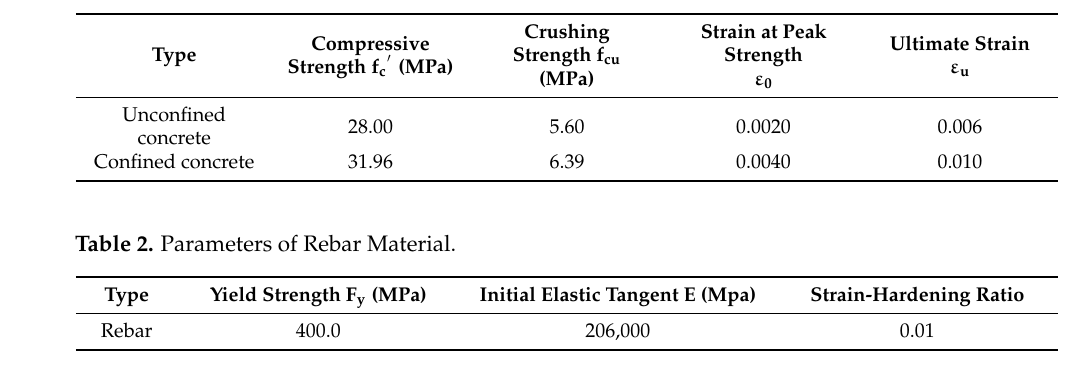
Table 1. Parameters of Concrete Material.